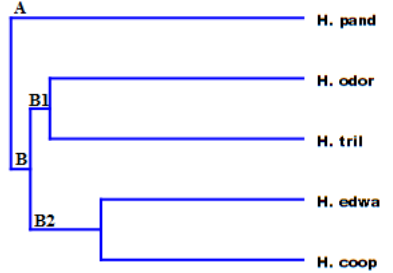
Figure 6. Hierarchical cluster analysis of the EOs obtained from all the studied species of Helichrysum .